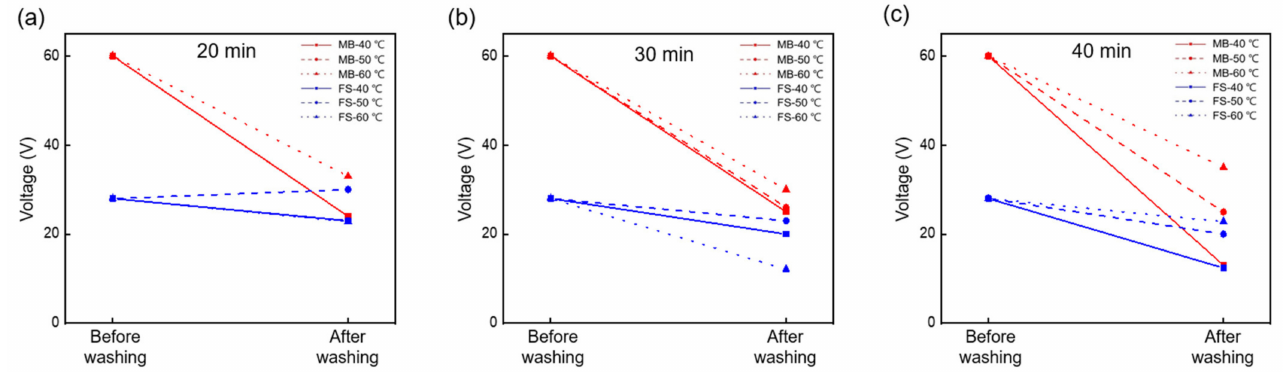
Figure 5. Variation in the maximum peak-to-peak voltage of the FTENGs based on the FS and MB fabrics after washing for ( a ) 20, ( b ) 30, and ( c ) 40 min. The red and blue lines represent the voltages of the FTENGs based on the MB and FS fabric, respectively. The solid, dashed, and dotted lines represent washing at 40, 50, and 60 ◦ C, respectively.